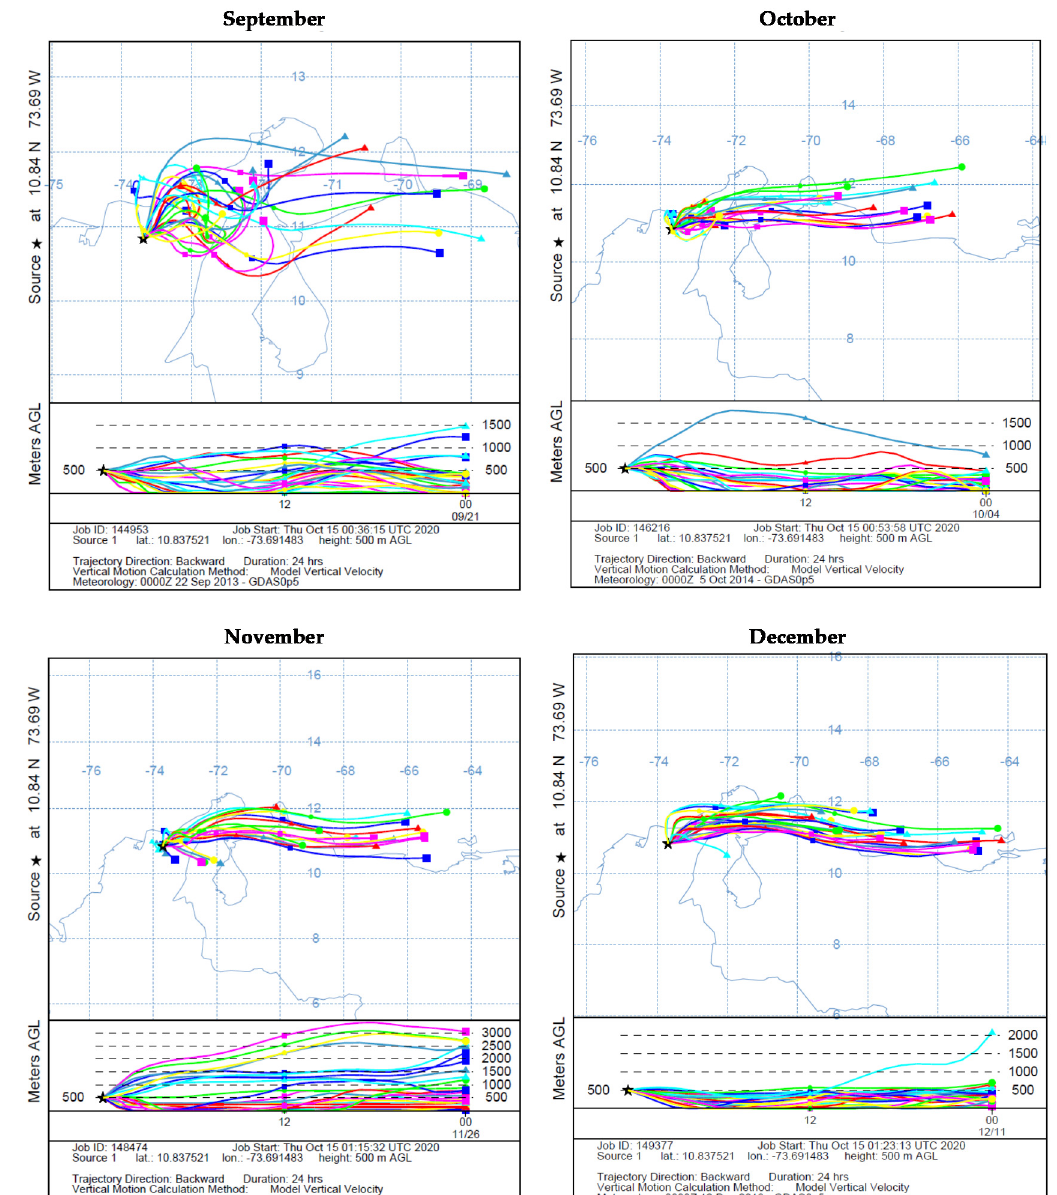
Figure 7. Backward trajectories (ensemble) simulated by the NOAA HYSPLIT ending at 00:00UTC on 22 September 2013, 4 October 2014, 27 November 2015, and 12 December 2018, respectively, in the area studied in the SNSM. (For interpretation of the references to color in this figure legend, the reader is referred to the web version of this article.).